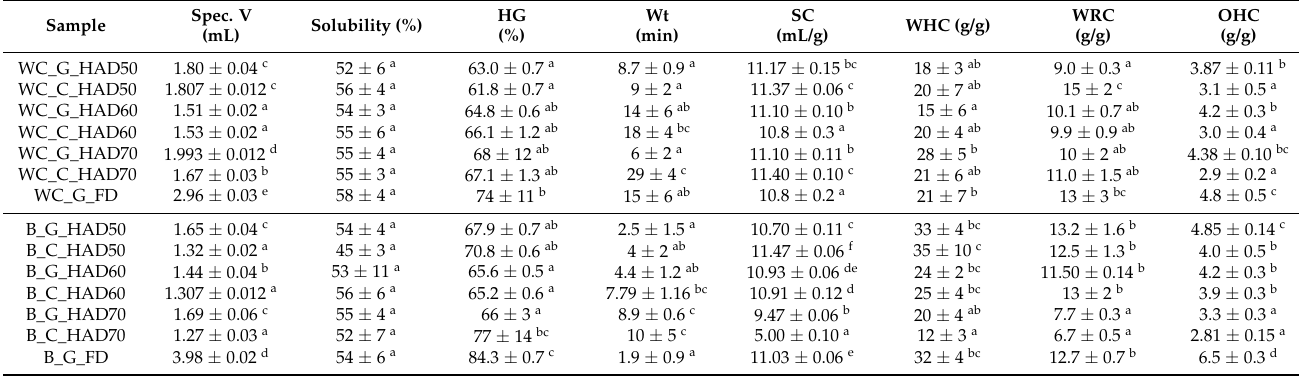
Table 4. Results of specific volume, solubility, hydration and water retention properties and emul- sifying properties of white cabbage (WC) and broccoli (B) powders. Spec V: specific volume (mL); % solubility expressed as a percentage; HG: hygroscopicity (%) (g water /100 g sample ); Wt: wetting time (min); SC: swelling capacity (mL/g); WHC: water holding capacity (g/g); WRC: water retention capacity (g/g); OHC: oil holding capacity (g/g). G: ground; C: chopped; HAD: hot-air drying at 50, 60 and 70 ◦ C; FD: freeze drying. Mean ± standard deviation of three